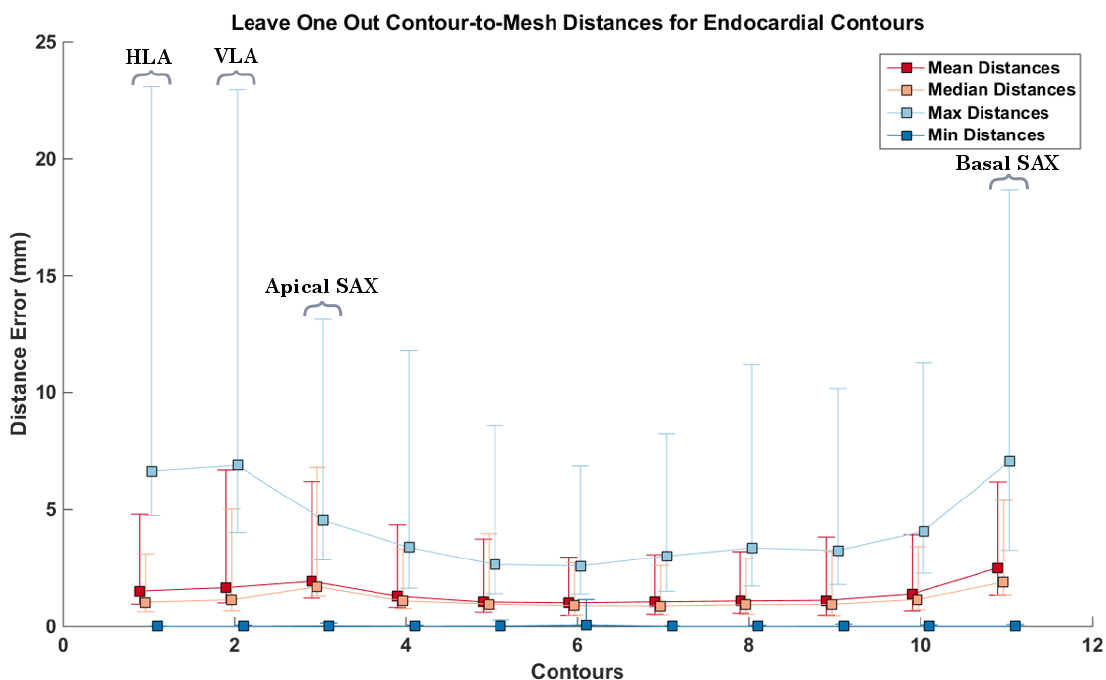
Figure 11. Contour-to-mesh distances for all 24 cases, having built the meshes without the respectively excluded contour. Each error bar represents the distribution of distances for each of the respective statistical measurement. Each square represents the mean of each statistical measure, with the upper and lower notches representing the minimum and maximum values, respectively. Top : epicardial contour-to-mesh distances; bottom : endocardial contour-to-mesh distances. The y -axis represents the contour index. 1–2 represent the LAX, 3–11 represent the apex to the base,